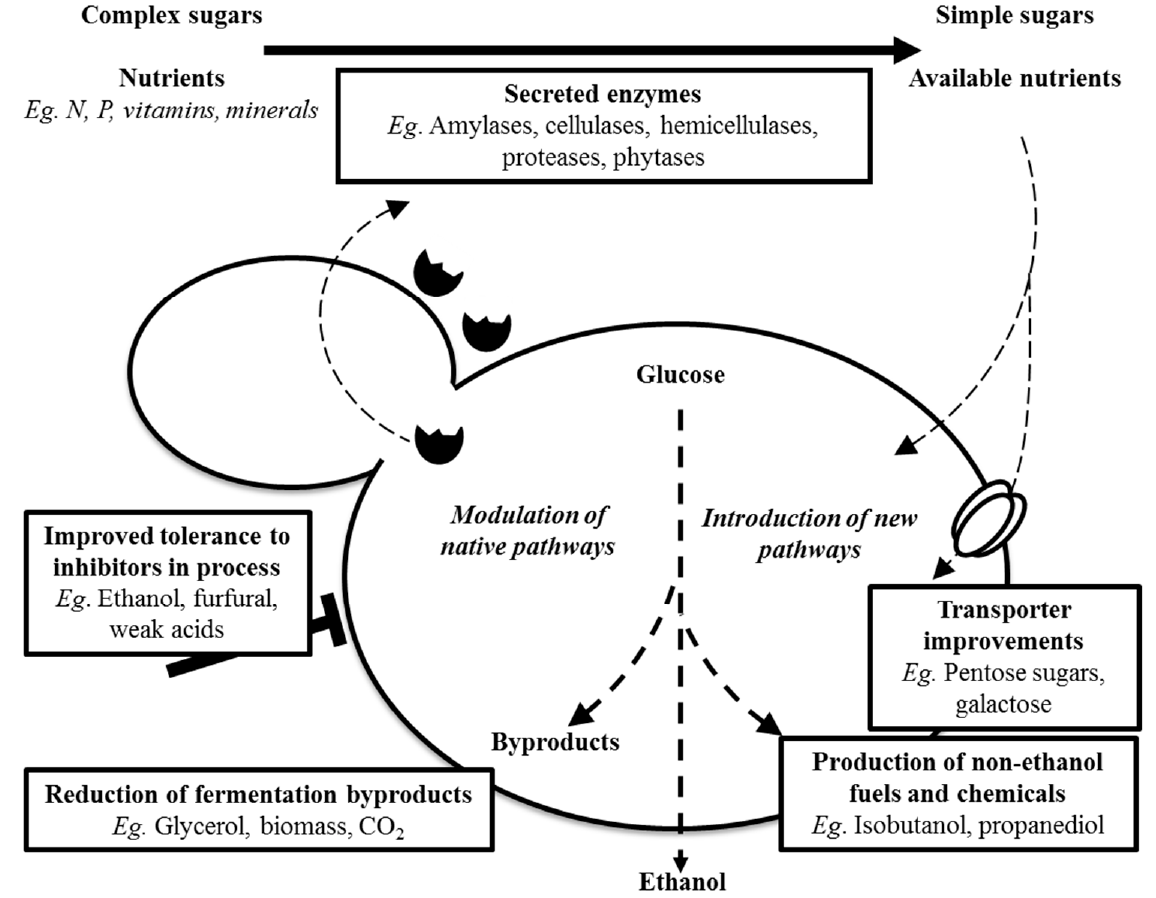
Figure 6. Yeast strain improvement opportunities (adapted from [33]).